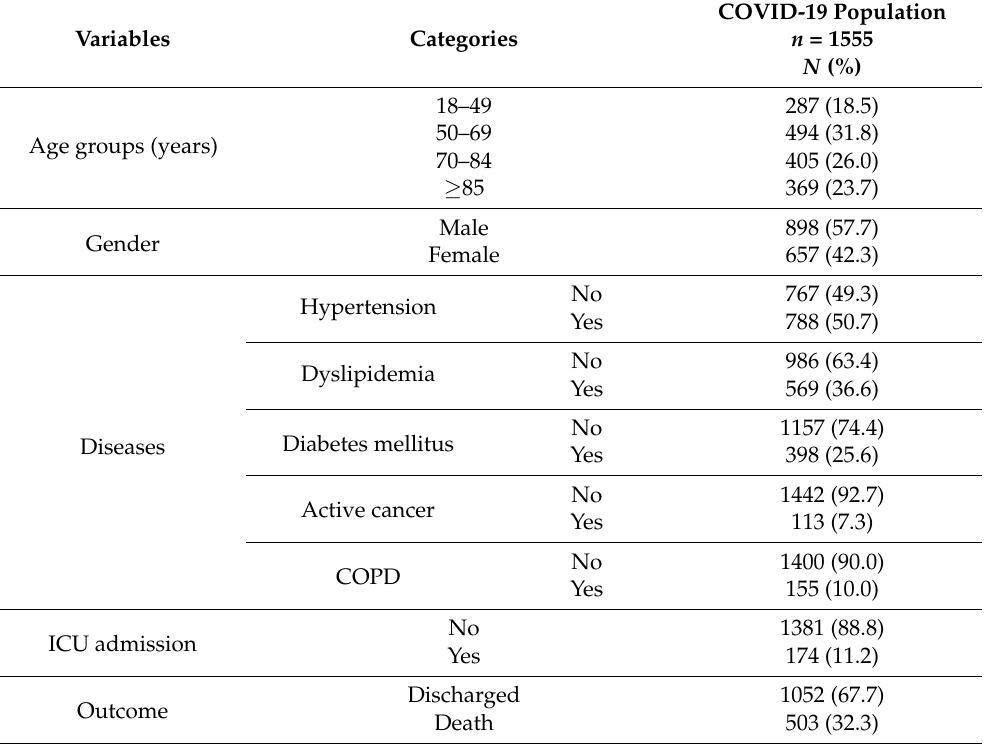
Table 1. Demographic characteristics in the multi-center cohort-study on the impact of admission serum albumin levels for the prediction of <30 days in-hospital all-cause mortality in COVID-19 patients, Spain, August–November 2020 ( n =